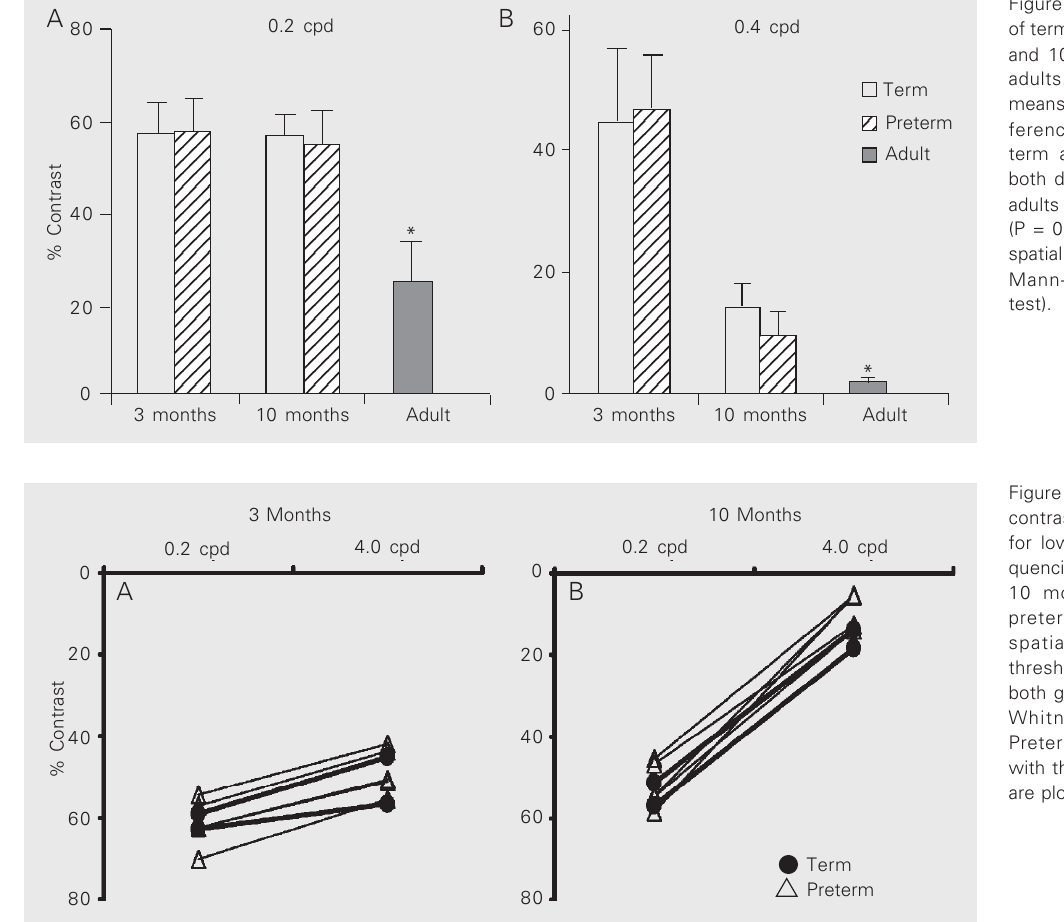
Figure 1. Contrast thresholds of term and preterm infants at 3 and 10 months of age and of adults. Data are reported as means ± SD. No significant dif- ference was found between term and preterm infants but both differed significantly from adults for low spatial frequency (P = 0.008; A) and for medium spatial frequency (P ≤ 0.001; B; Mann-Whitney rank sum T- test).